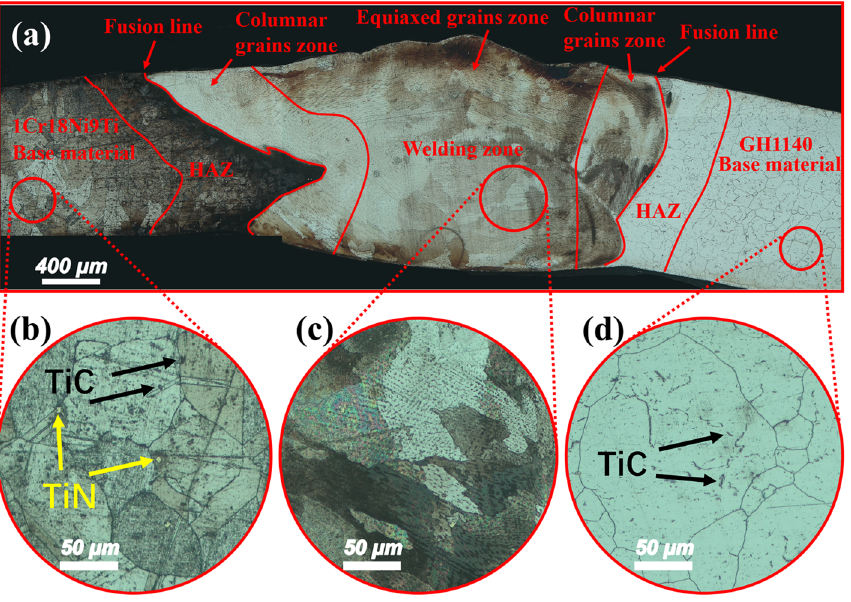
Figure 7. ( a ) Initial microstructural characteristics of the weld zone in the combustion liner. ( b ) Am- plified organization of 1Gr18Ni9Ti base material; ( c ) amplified organization of weld region; ( d ) am- plified organization of GH1140 base